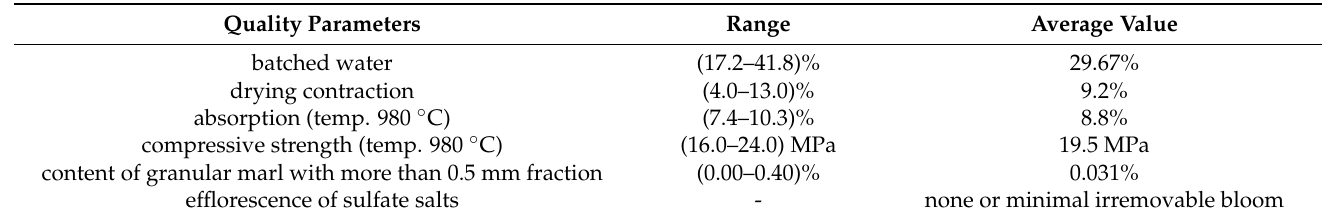
Table 2. Quality parameters of ceramic building materials produced from the local Pliocene clay deposit.